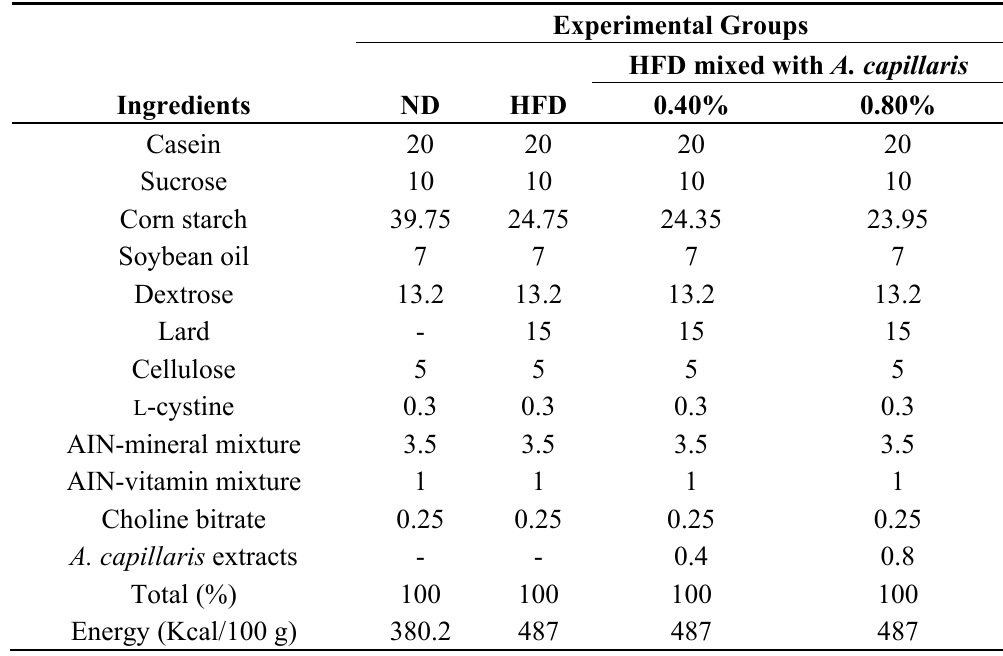
Table 5. Composition of the experimental